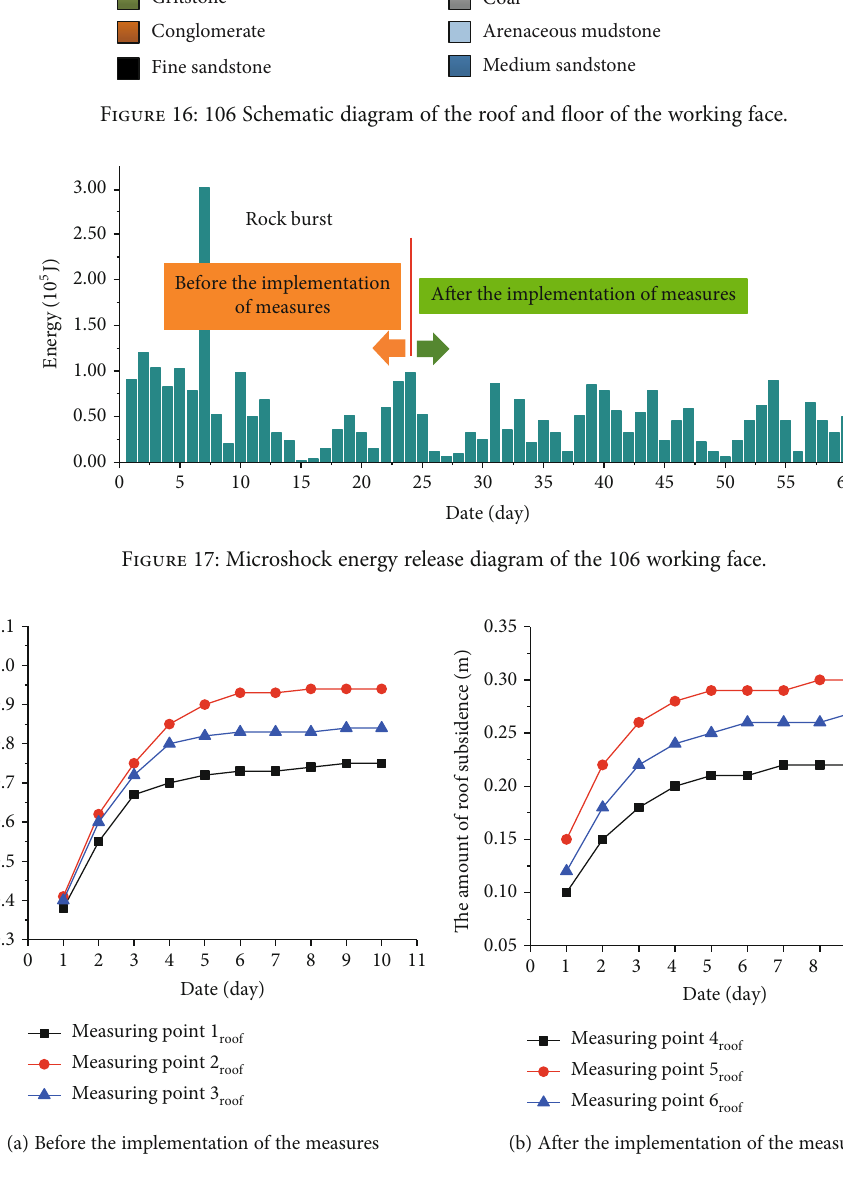
Figure 18: Comparison of the amount of roof subsidence before and after the implementation of antiscour measures on the working